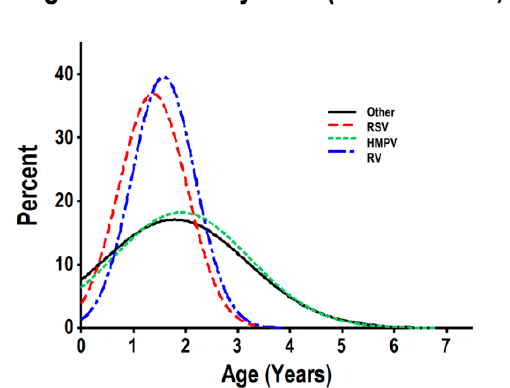
Figure 3. Normalized histogram of age distribution analysis of viral respiratory infections, according to virus, in severely premature children. Individual rhinovirus (RV; blue), RSV (red), HMPV (green) and other viruses (black).